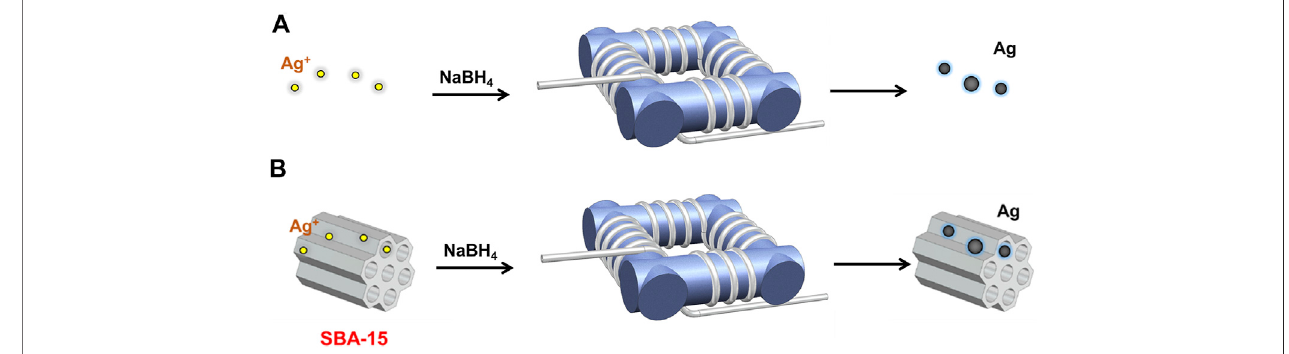
FIGURE 1 | Schematic diagram of the experimental setup for (A) silver nanoparticle synthesis, and (B) supported silver nanocatalysts